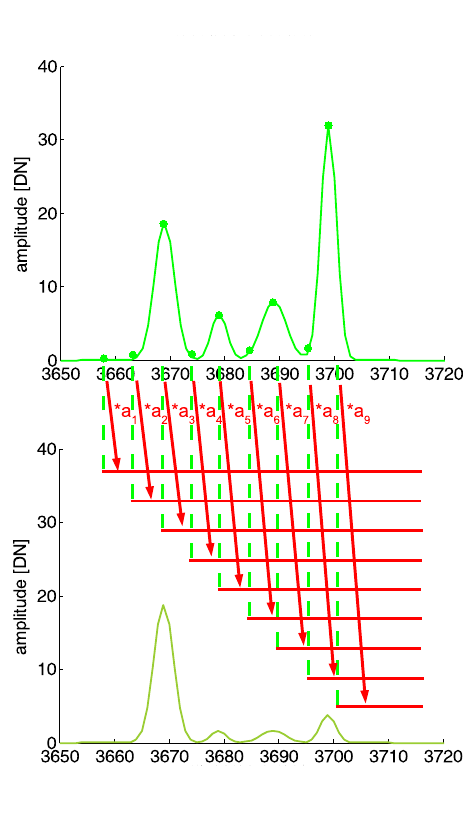
Figure 4: Integral attenuation